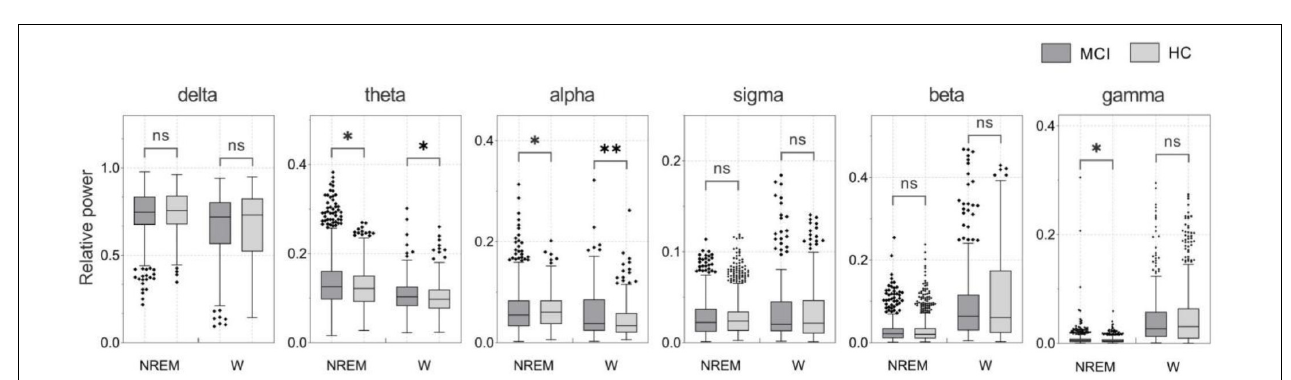
FIGURE 3 | ROC curves and AUC values of NREM sleep EEG and awake EEG (A) SVM classifier (B) GRU network.